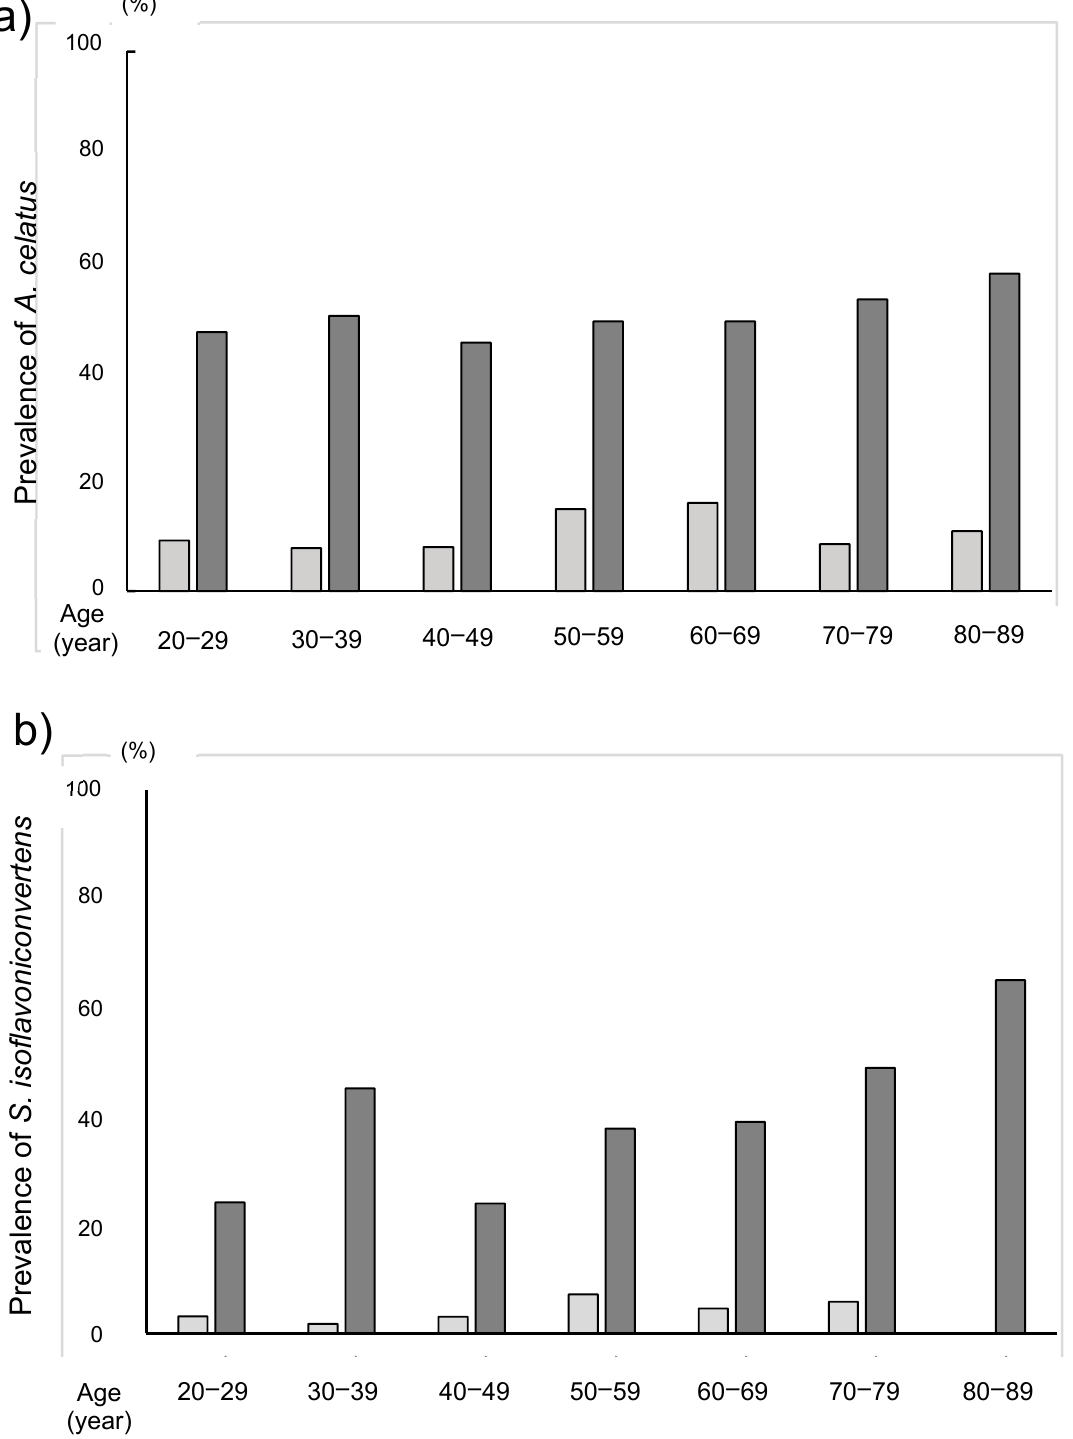
Figure 6. The prevalence of ( a ) Asaccharobacter celatus and ( b ) Slackia isoflavoniconvertens among the seven age groups by decades.